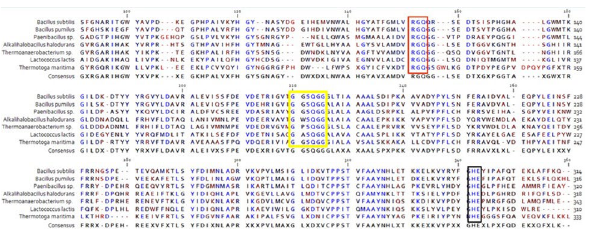
Fig. 2 Multiple alignment of AXE-HAS10 with other related CE7 family members displaying the GxSxG (green rectangle), -RGQ- (yellow stars), and -HE- (green stars) conserved motifs performed with CLC Sequence Viewer 8.0. The presented acetylxylan esterases are B. subtilis (accession number: 1L7A), B. pumilus (accession number: 2xlb), Paenibacillus sp. (accession number: 6AGQ_A), Halalkalibacterium halodurans (accession number: QCC21369.1 (AXE-HAS10)), Thermoanaerobacterium sp. (acces- sion number: 3FCY), Lactococcus lactis (accession number: 7CUZ_A), and Thermotoga maritima (accession number: 1VLQ).